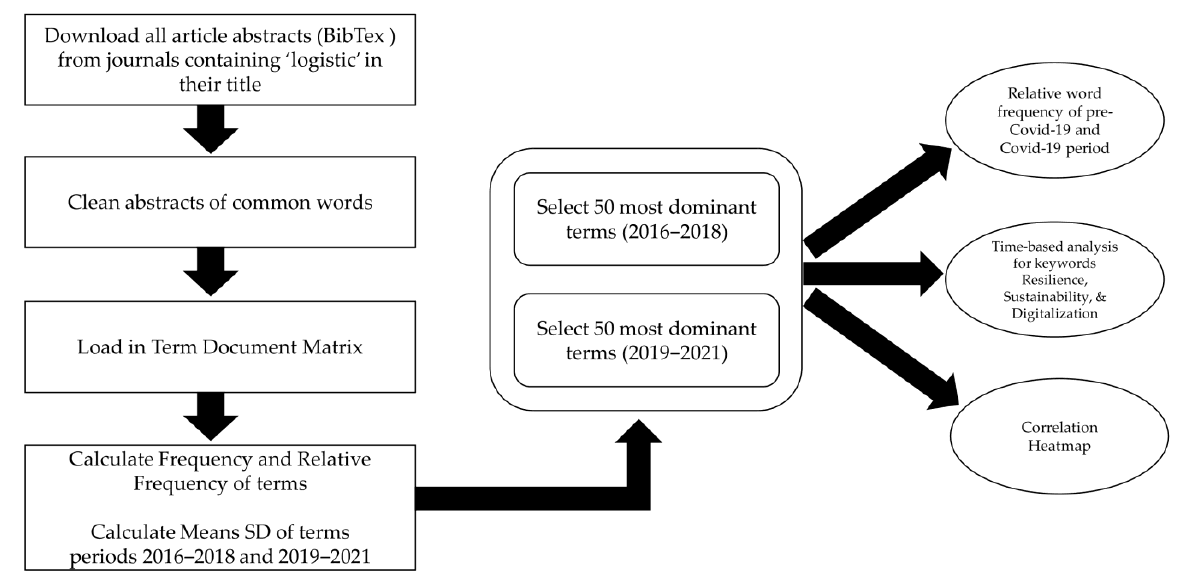
Figure 2. Schematic diagram of the text mining